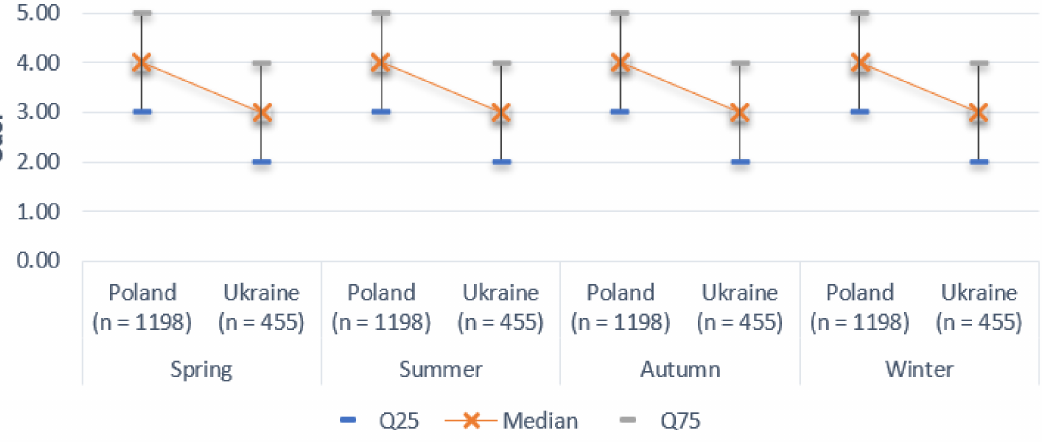
Figure 4. Assessment of tap water odor during individual periods of the year by groups of respon- dents from Poland and Ukraine.